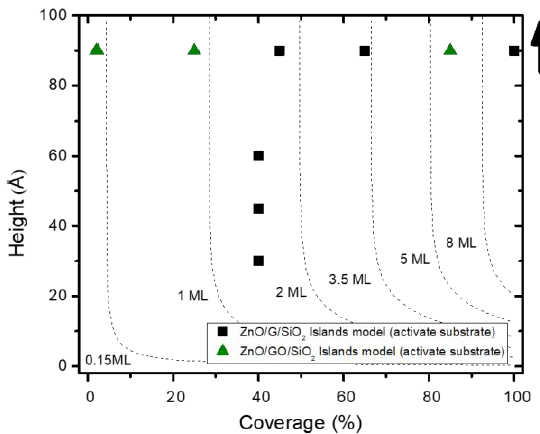
Figure 2. Results for the inelastic peak shape analysis for the growth of ZnO on G / SiO 2 (black squares) and GO (green triangles).